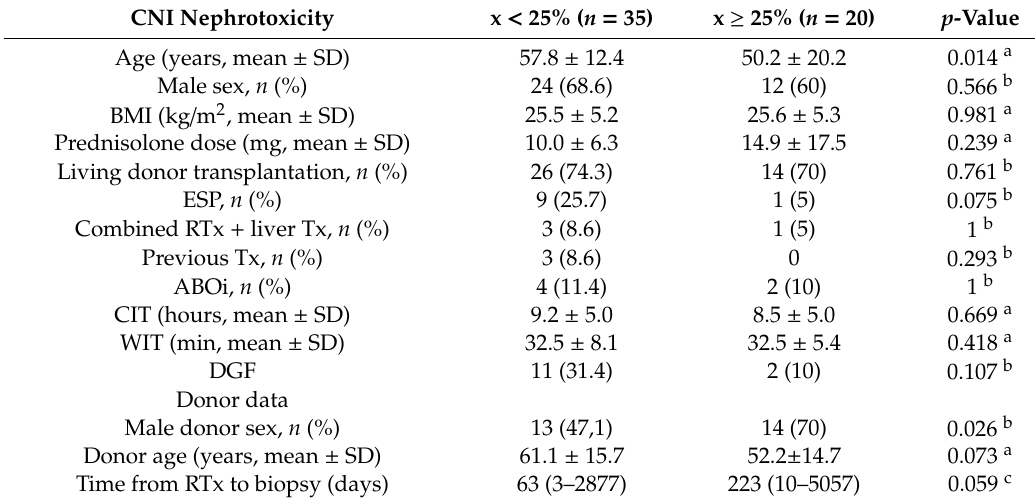
Table 1. Patient characteristic: Histological